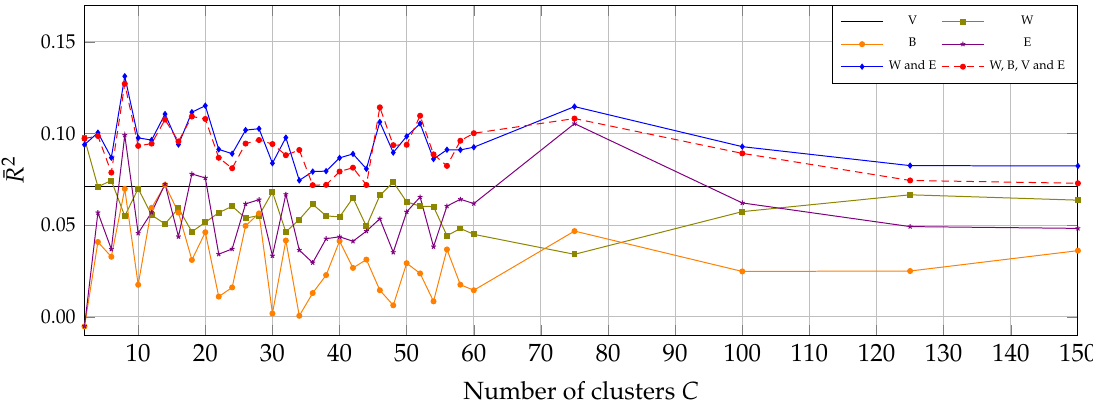
Figure 9. Adjusted coefficient of determination in the multivariate linear regression between different combinations of SH measures (V: log-transformed global variability or MDC, W: log-transformed within-class variability, B: log-transformed between-class variability, E: entropy) computed from multitemporal data and the Shannon index (response variable) depending on the number of clusters.